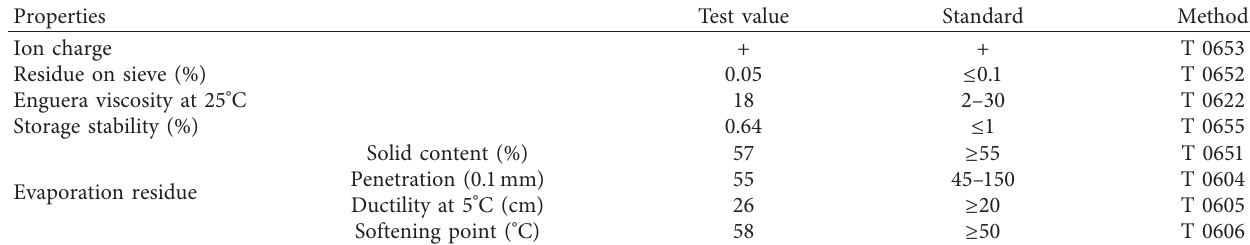
Table 2: Basic properties of SBS-modified emulsified